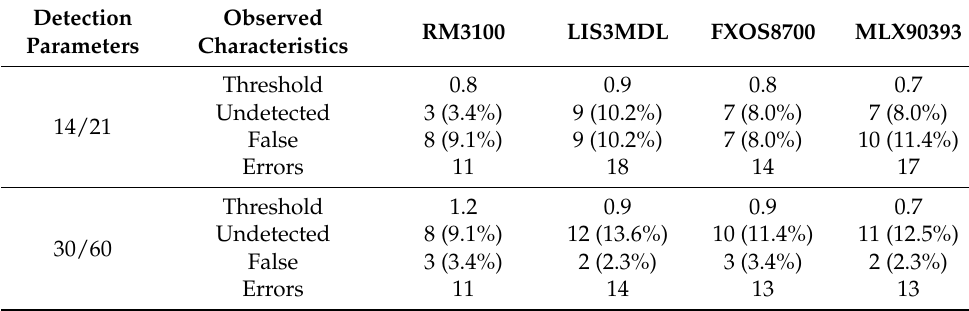
Table 6. Optimal threshold level and detection results for measurement 1.